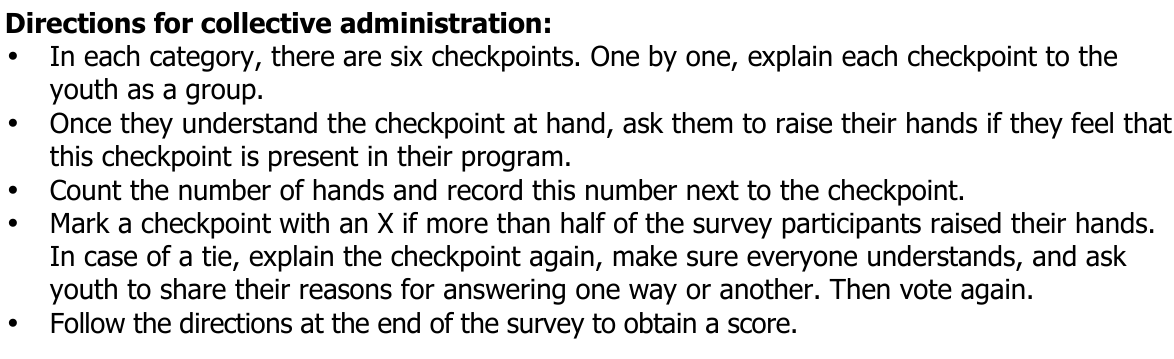
Learning Environment